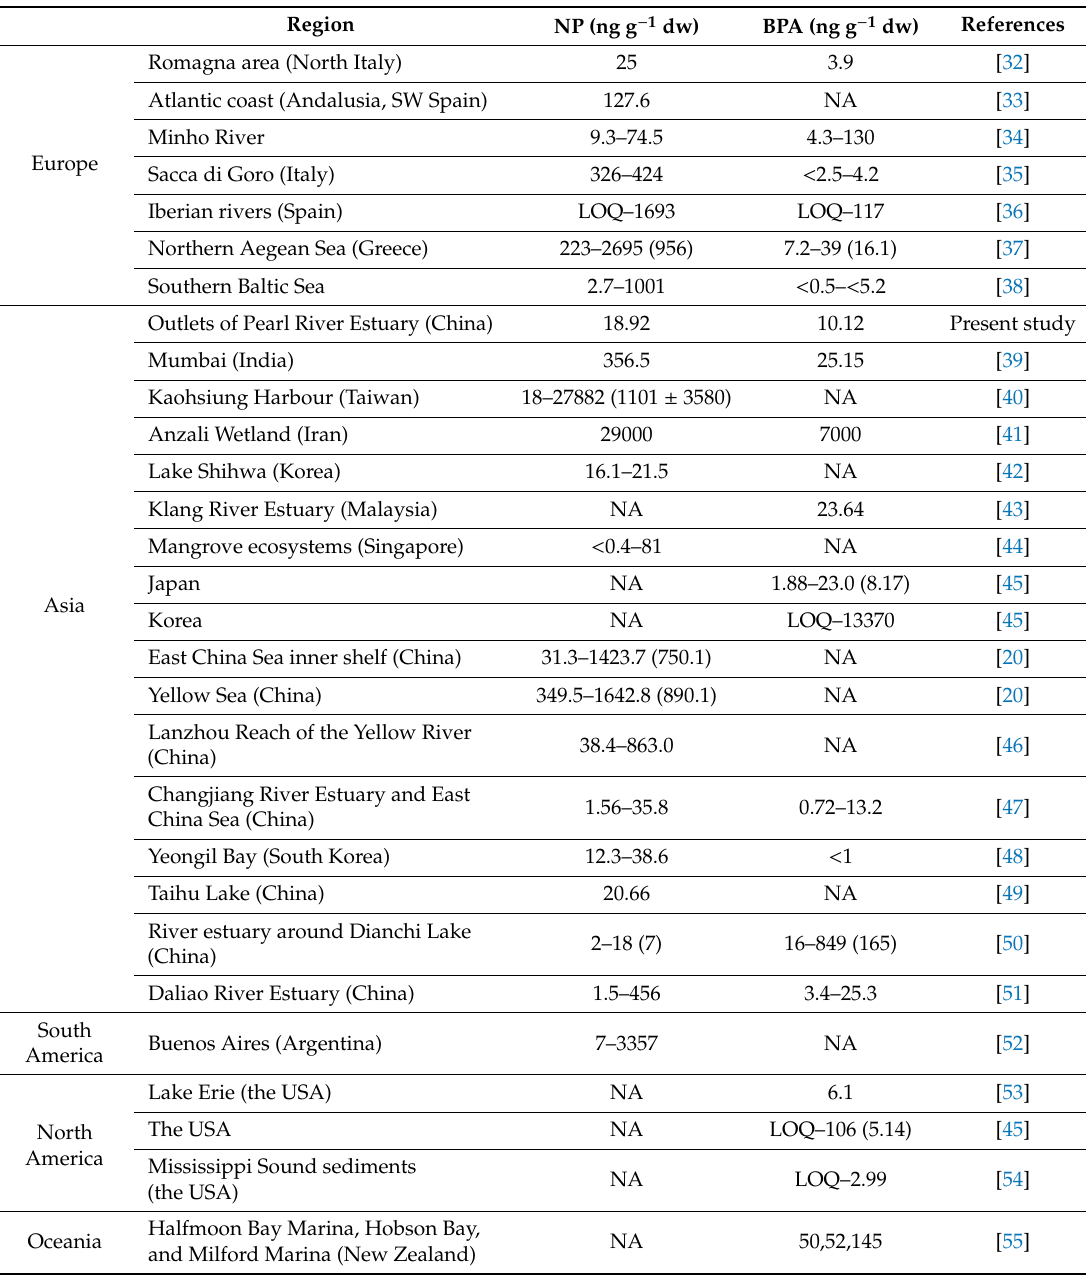
Table 1. Concentrations of NP and BPA in surface sediments (0–6 cm) from di ff erent sampling sites